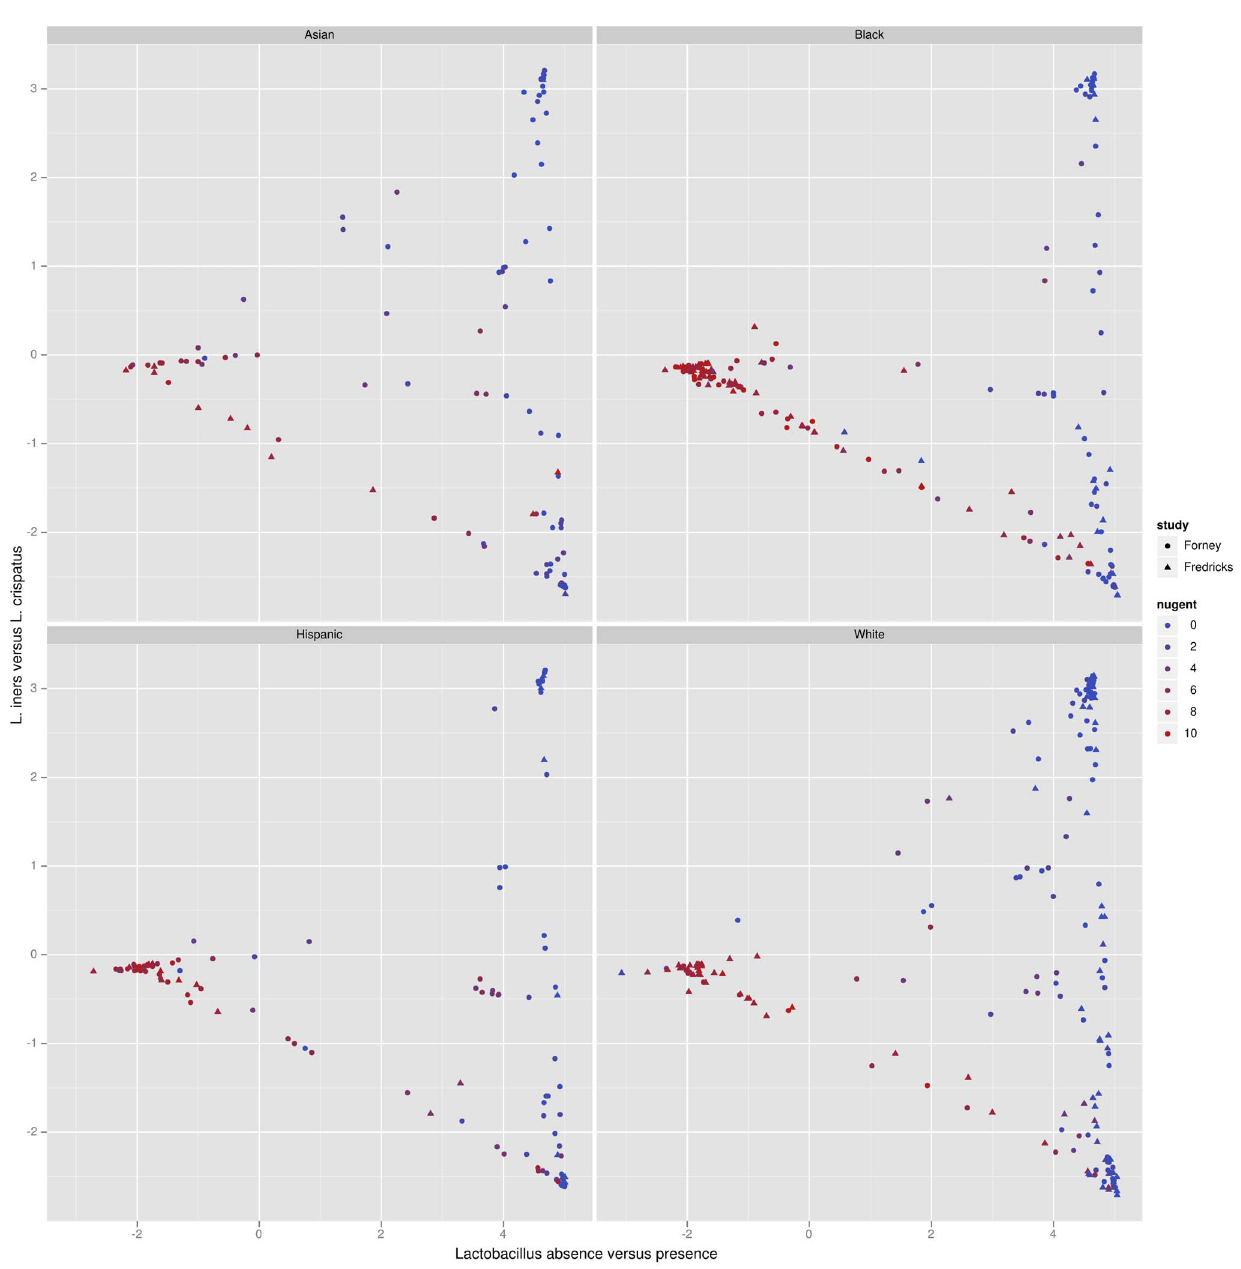
Figure 6. Edge principal components analysis (edge PCA) applied to the combined Forney and Fredricks data set and plotted separately. The axes for the edge principal components plot are described in Figures 4 ( x -axis) and 5 ( y -axis). The Nugent score is a diagnostic score for bacterial vaginosis, with high score indicating bacterial vaginosis.